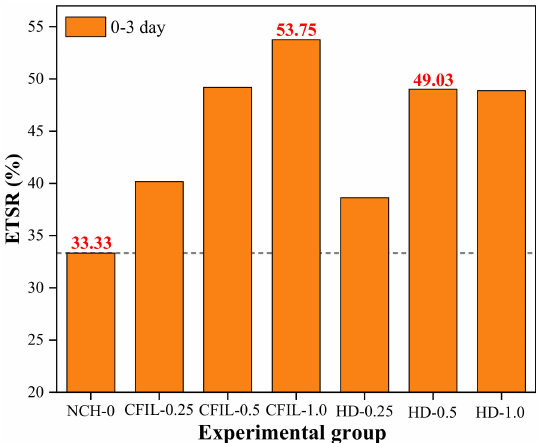
Figure 9. Early strength ratio of TS (ETSR) for each experimental group.